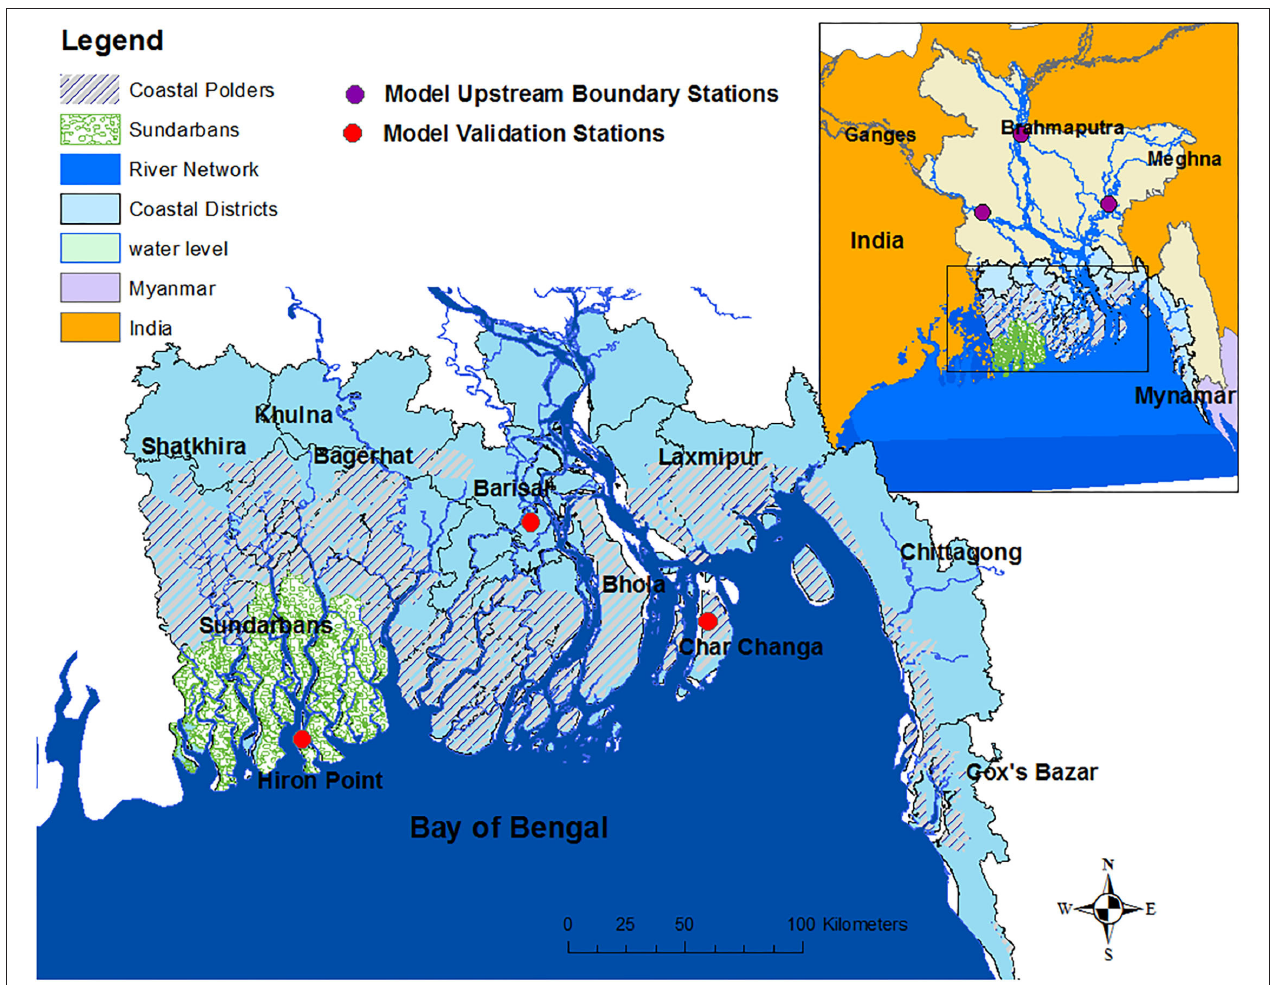
FIGURE 1 | Study area: coastal areas (districts) and major features (Sundarbans, polders) of Bangladesh in in Ganges Brahmaputra Meghna Basin (model upstream boundary and validation locations are given in purple and red circles, respectively).